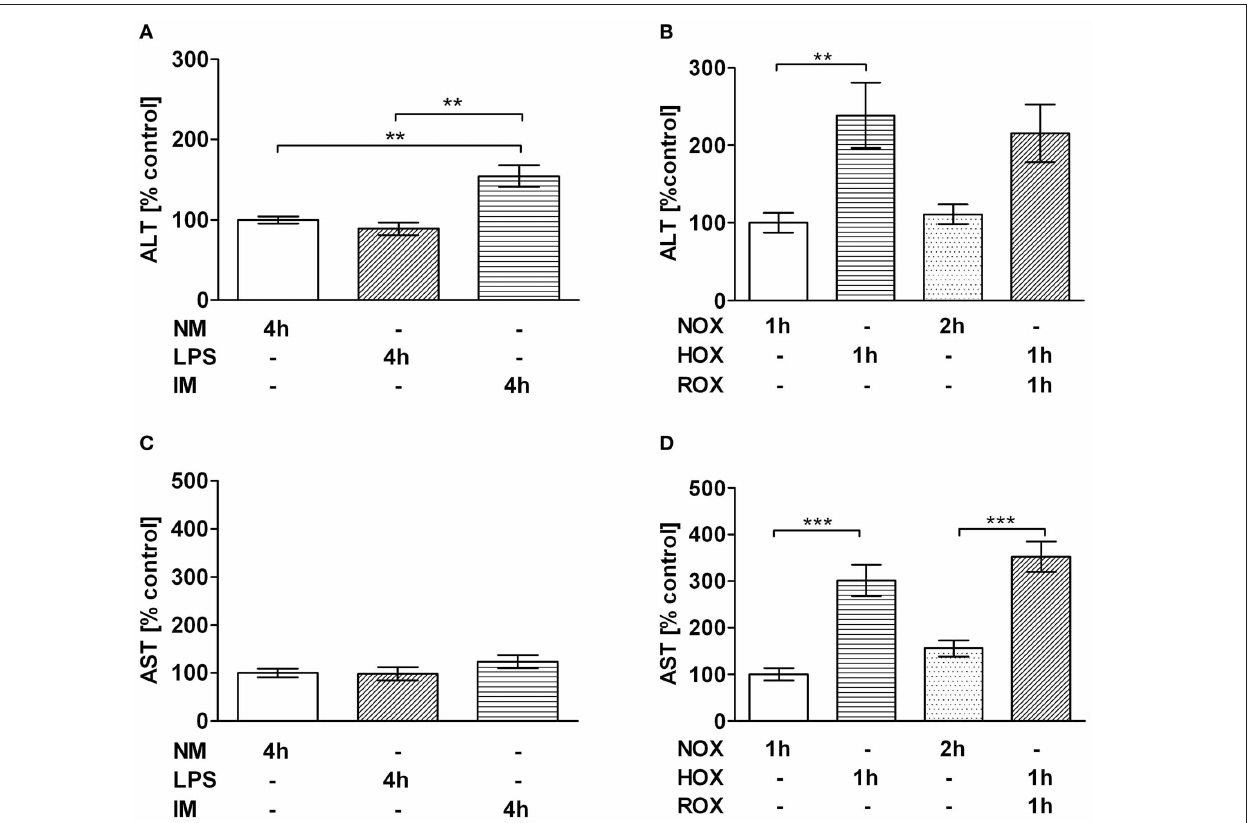
FIGURE 1 | Effect of IM (A,C) and HOX/ROX (B,D) on the release of ALT (A,B) and AST (C,D) from PCLS. (A,C) PCLS were incubated in NM only or NM containing LPS or LPS + IM at 37 ◦ C. ALT/AST samples were taken after 4h incubation. (B,D) PCLS were incubated in NM which was either equilibrated with air (NOX, ROX) or nitrogen (HOX). The medium for ALT/AST analysis was taken at the end of the hypoxic phase (1h) and the end of the